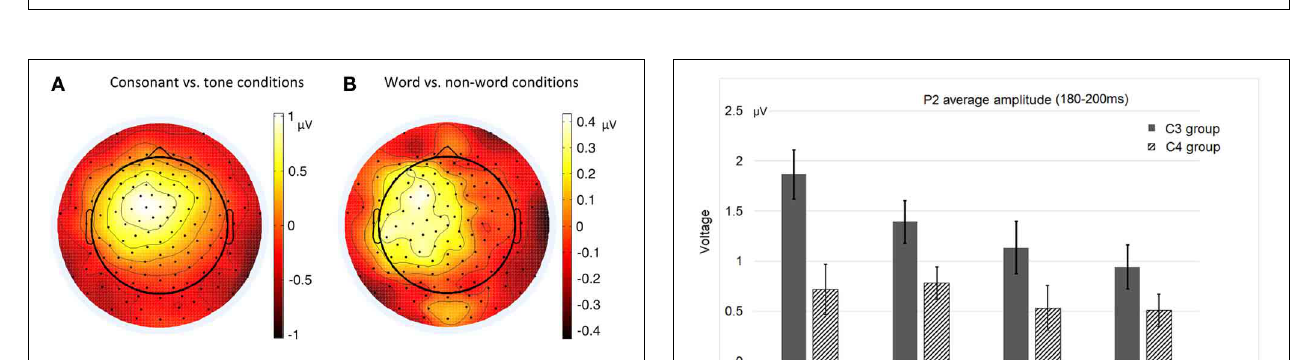
FIGURE 3 | Average ERP waveforms of the C3 and C4 electrode groups under the four conditions of Experiment 1. (A) Word, consonant condition; (B) Non-word, consonant condition; (C) Word, tone condition; (D) Non-word, tone condition.